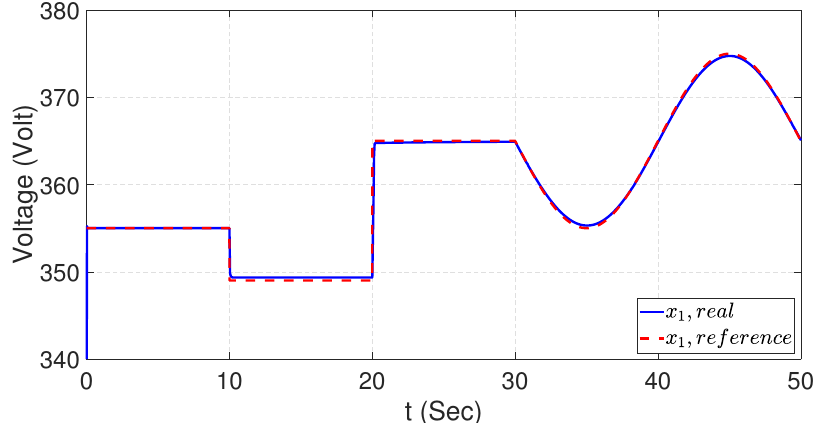
Figure 3. AES voltage trajectory tracking.